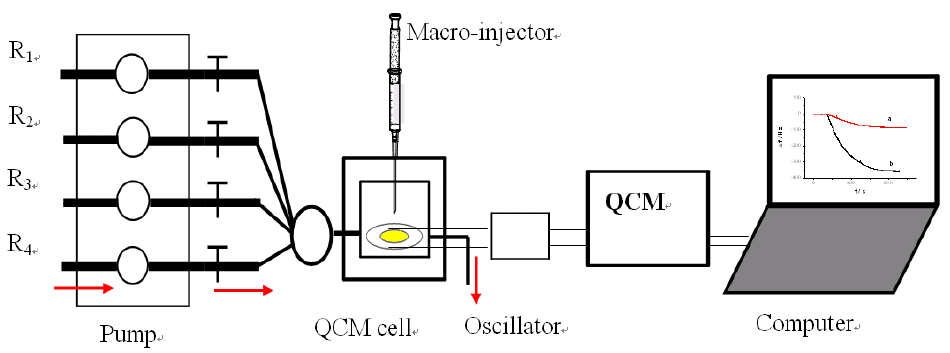
Figure S3. Schematic representation of the QCM-based sensor for detection of the Hg